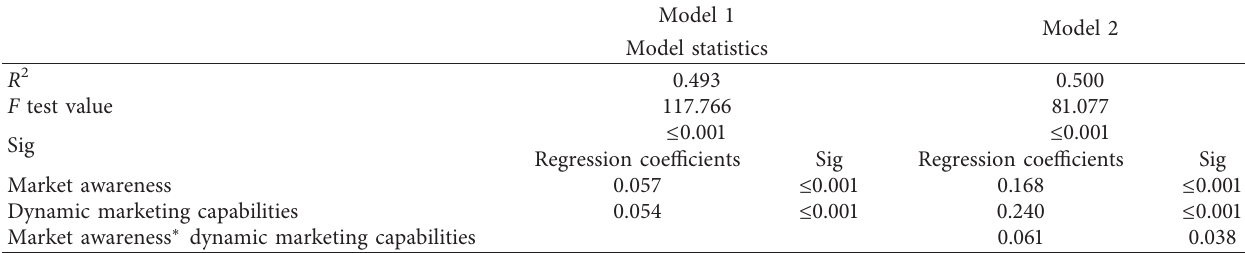
Table 4: Analysis of the adjustment effect of dynamic marketing capabilities (market awareness ➔ sustainable competitive advantage).